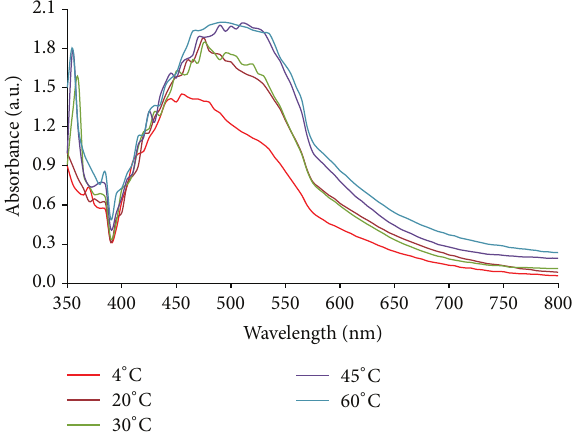
Figure 4: XRD pattern of biosynthesized AgNPs (blue) and ref- erence XRD pattern of cubic silver (red). Synthesis conditions: silver nitrate concentration, 1mM; temperature, 45 ∘ C, extract pH, 9; extract concentration, 40